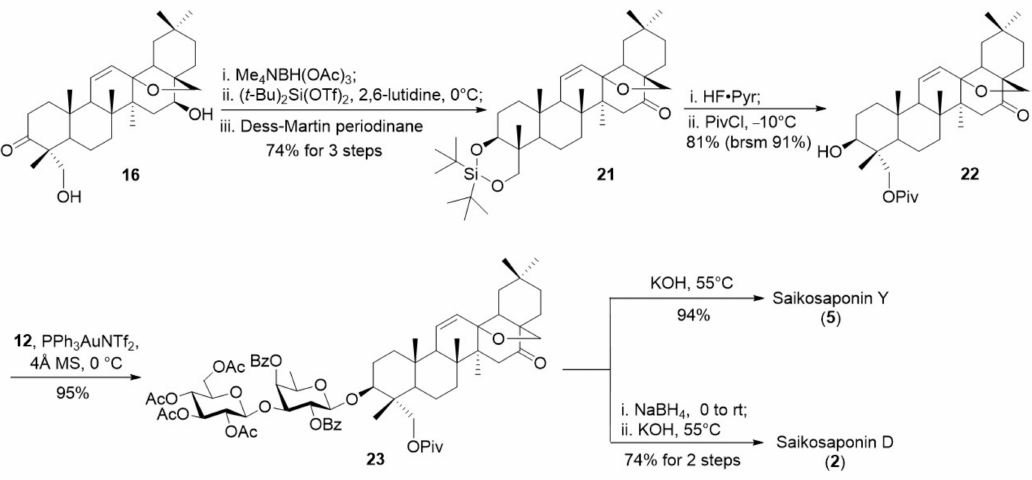
Scheme 6. Synthesis of saikosaponin D ( 2 ) and saikosaponin Y ( 5 ).